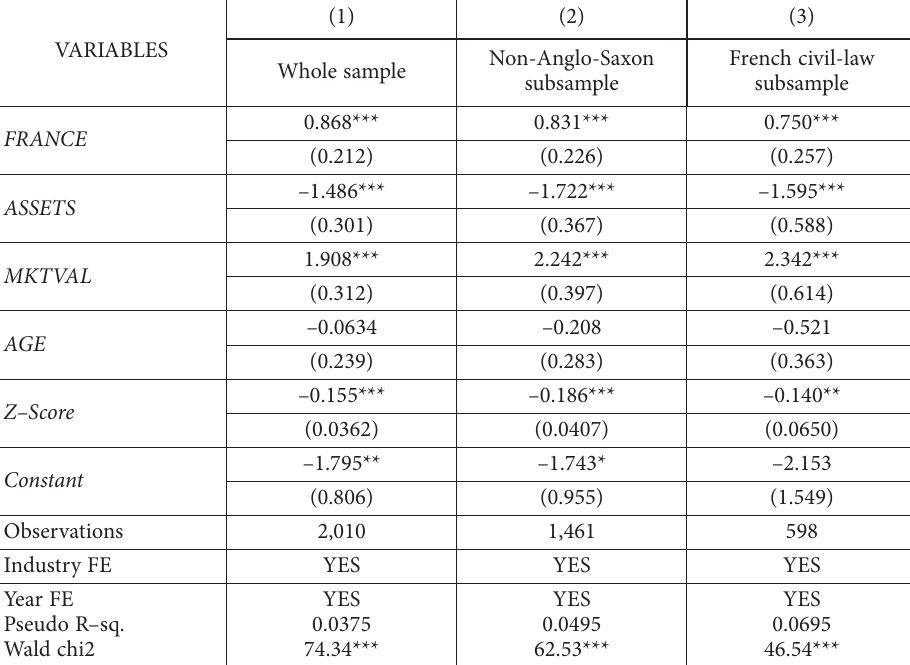
Table 6. Joint audits and the likelihood of just beating earnings